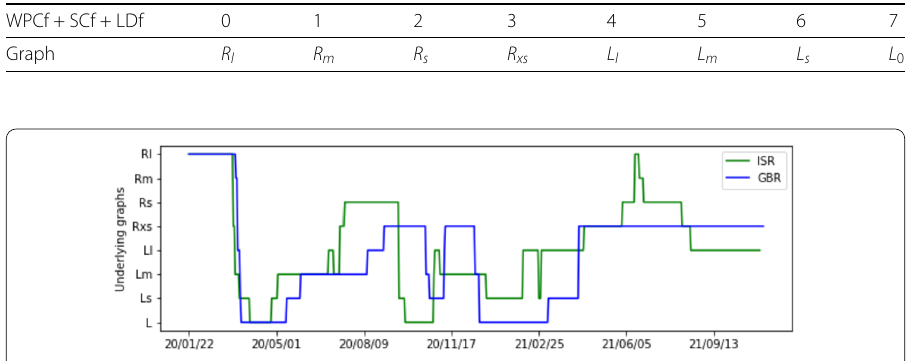
the table stand for: WPCf: workplace closing flag; SCf: school closing flag; LDf: lockdown flag. Figure 5 shows the temporal positions of the graphs for each country. Note that we leave the network probabilities ( p l , p rxs , p rs , p rm , p rl ) as model parameters that should